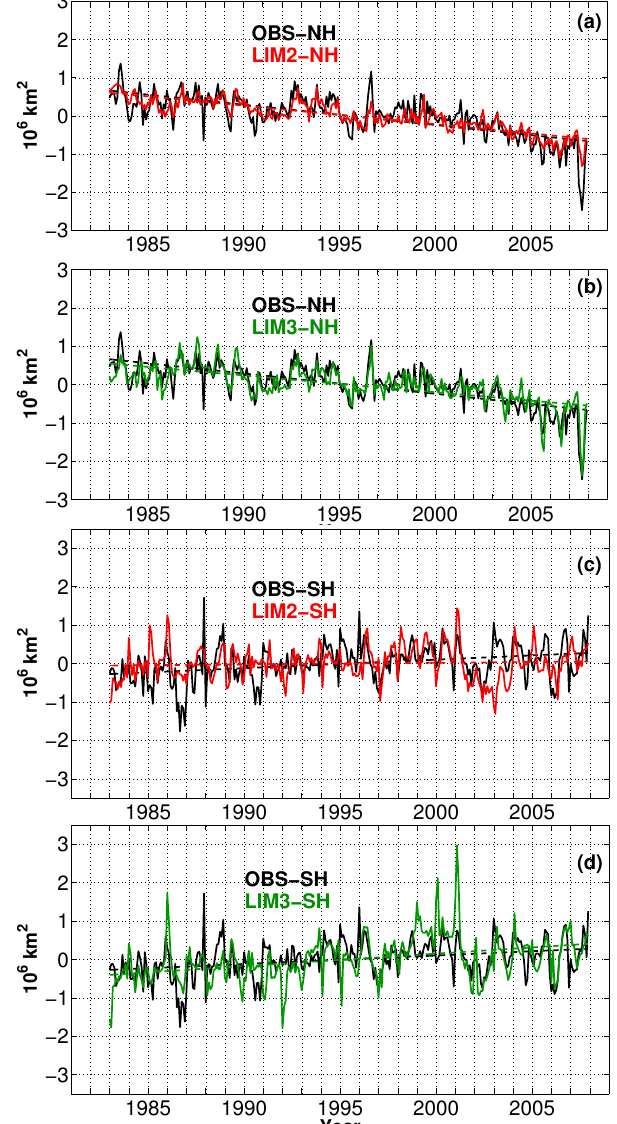
Fig. 2. Simulated and observed (EUMETSAT OSISAF, 2010) monthly anomalies of sea ice extent in the NH (panels a and b ) and in the SH ( c and d ), over the period 1983–2007. The dashed lines indicate the trends computed from linear regression over the same